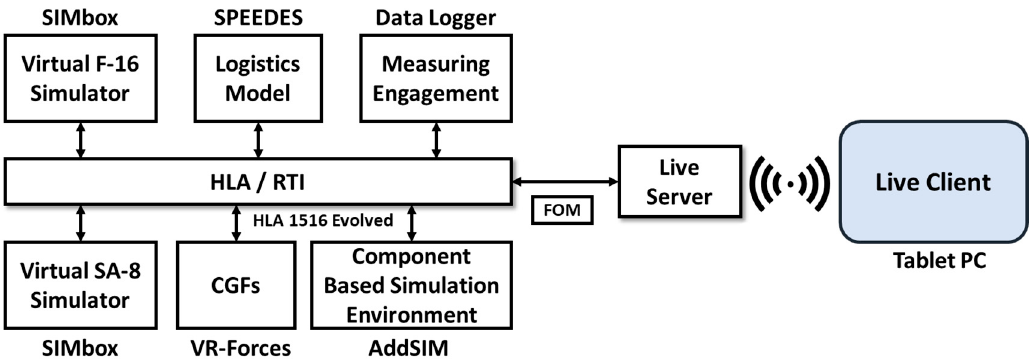
Figure 20. Interoperability through HLA (adapted from [50]).